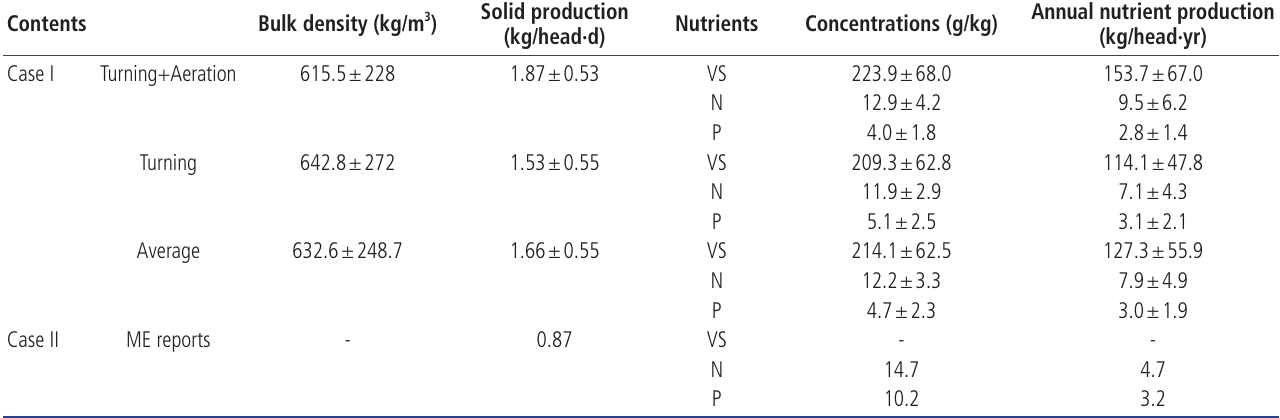
Table 2. Nutrient concentrations and production from swine breeding